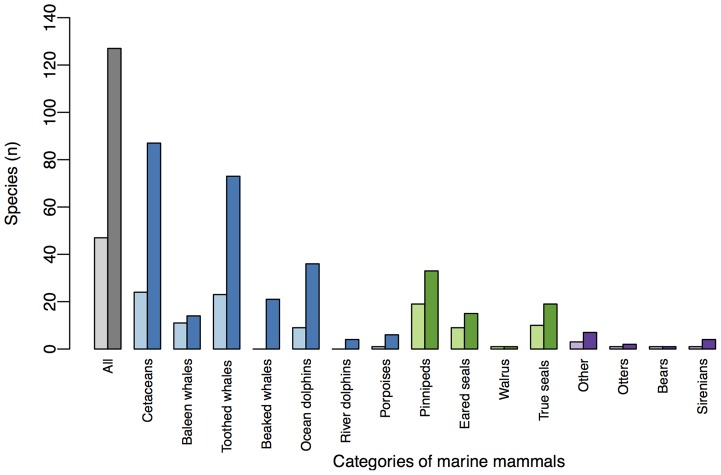
Species represented in population-level data in this study compared to marine mammal species overall.This study = light bars, marine mammals species overall = dark bars. Colors represent main taxonomic groups and their relevant sub-groupings: all marine mammals (grey), cetaceans (blue), pinnipeds (green), and other marine mammals (marine and sea otters, polar bears and sirenians) (purple).